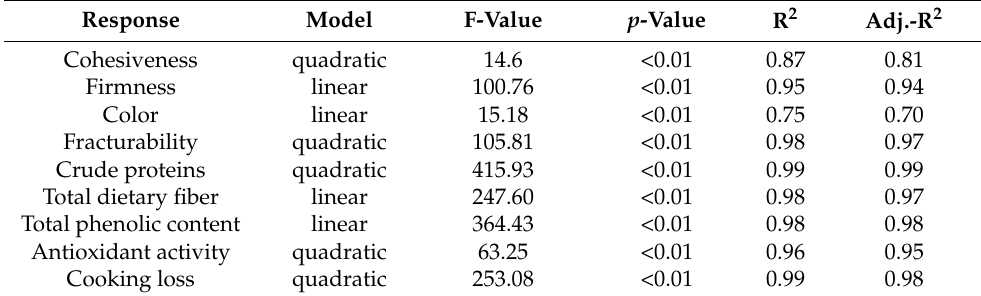
Table 2. ANOVA results for spent grain pasta and